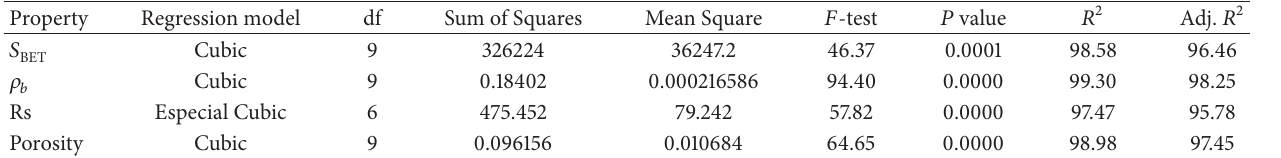
Table 6: Major statistical properties of variance analysis for the significance of regression